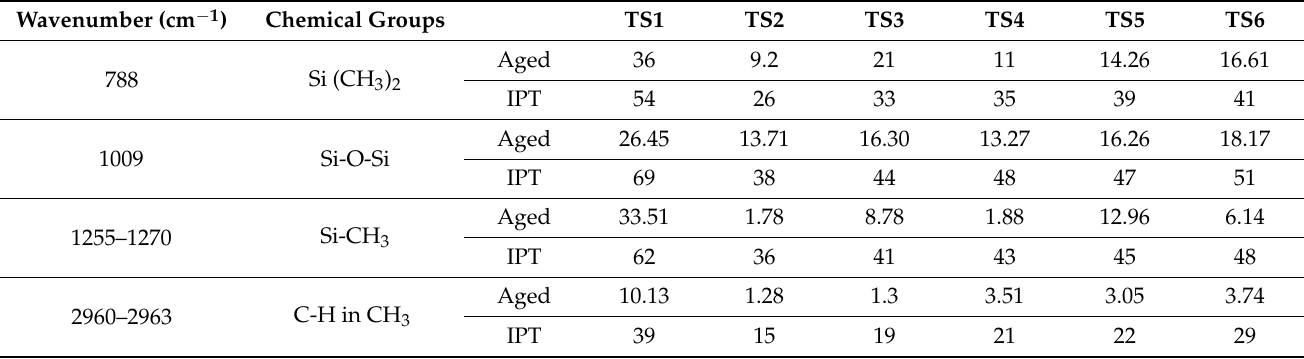
Table 2. Percentage loss of variations in different